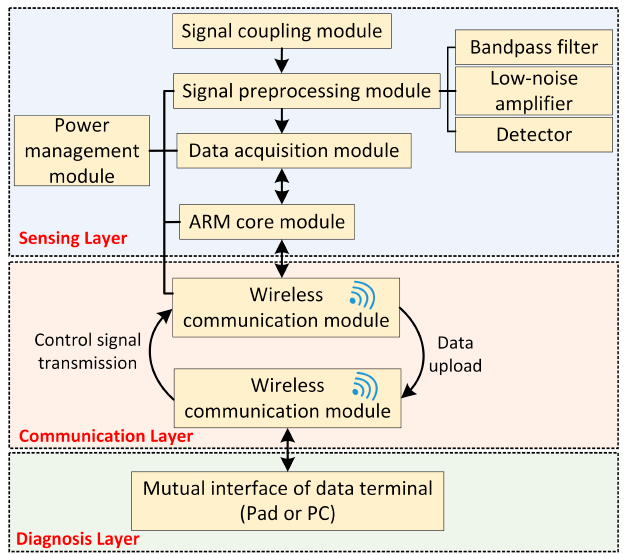
Figure 2. Overall design structure of the wireless TEV detection system.